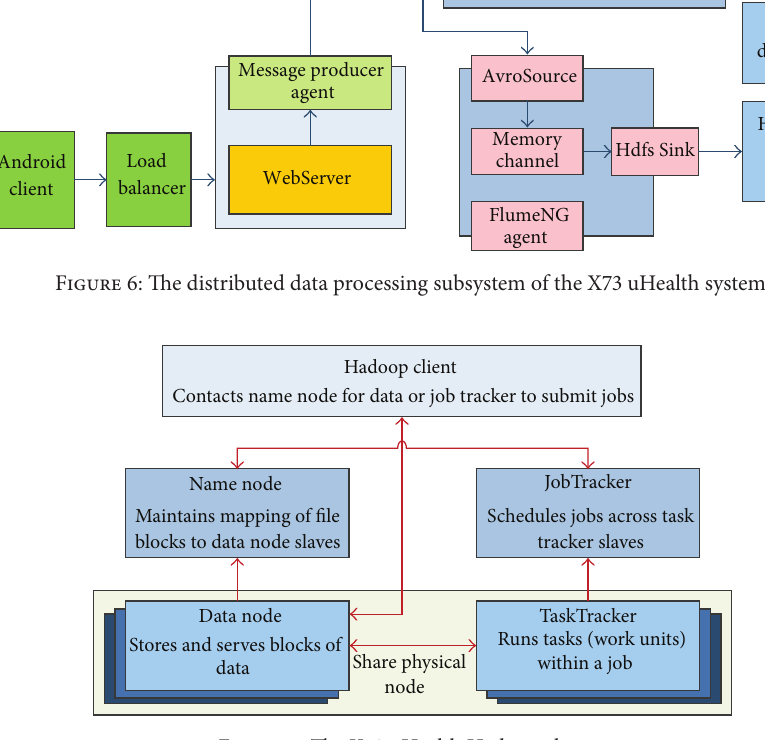
Figure 7: The X73 uHealth Hadoop